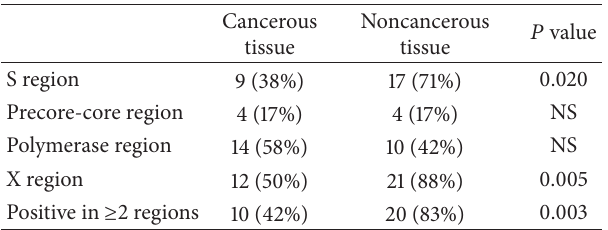
Table 3: Detection of HBV-DNA in 24HCC patients with HBsAg- negative and HBcAb-positive